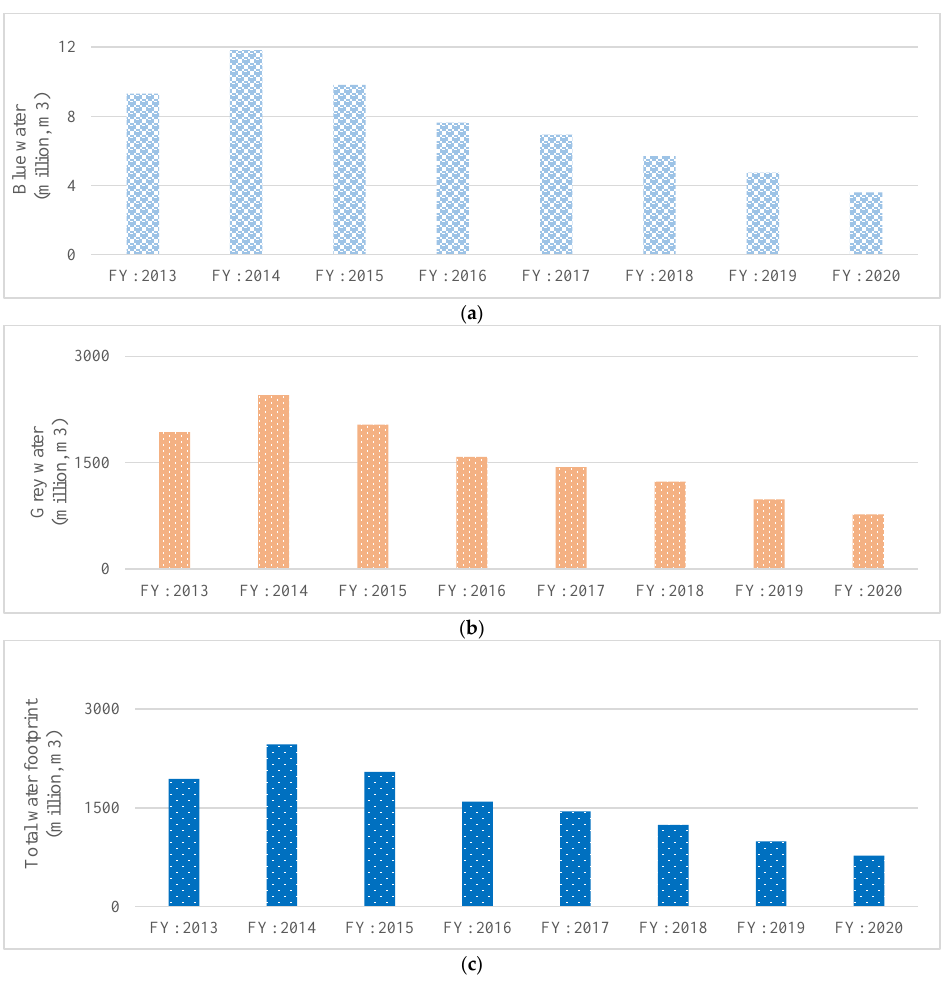
Figure 8. Water footprint of leather processing (FY 2013-FY2020). ( a ) Blue water footprint of leather processing (FY 2013-FY2020). ( b ) Grey water footprint of leather processing (FY 2013-FY2020). ( c ) Total water footprint of leather processing (FY 2013-FY2020) .